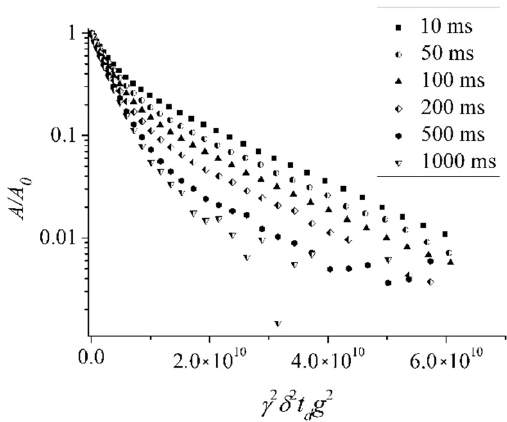
Figure 6. Diffusion decays of the fullerene derivative IX at different diffusion times t d . The values of t d are indicated in insertion. C = 64.4 mg/ml. Reprinted with permission from Ref. [37]. Copyright © 2016 Published by Elsevier B.V.